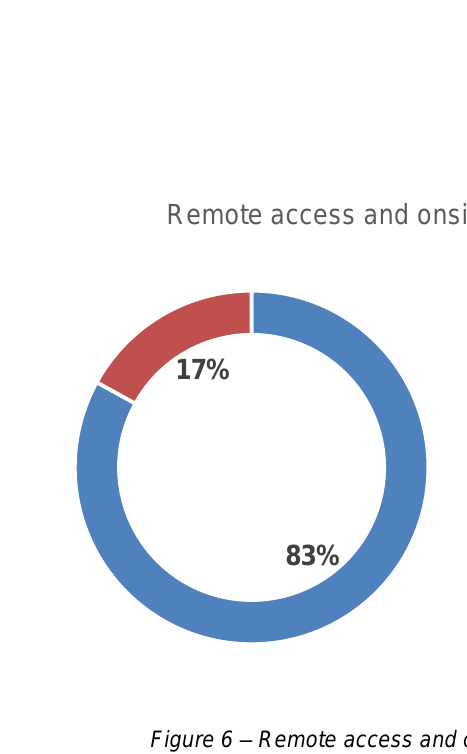
Figure 6 – Remote access and onsite access Слика 6 – Удаљени приступ и онсите приступ Рис. 6 – Удаленный доступ и доступ на